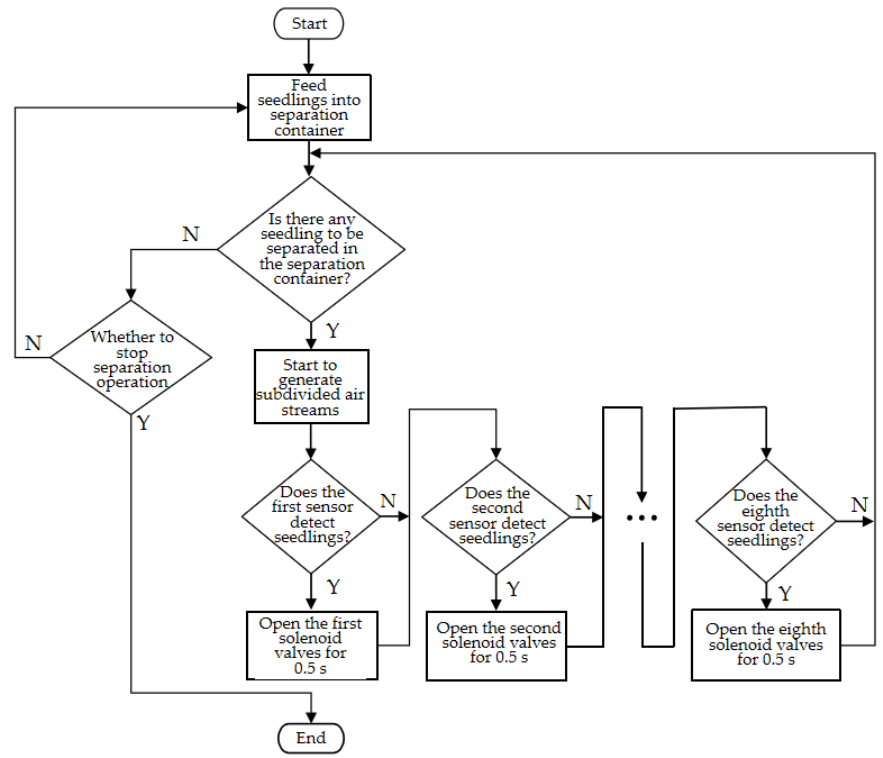
Figure 5. Flowchart for the feedback monitoring device.